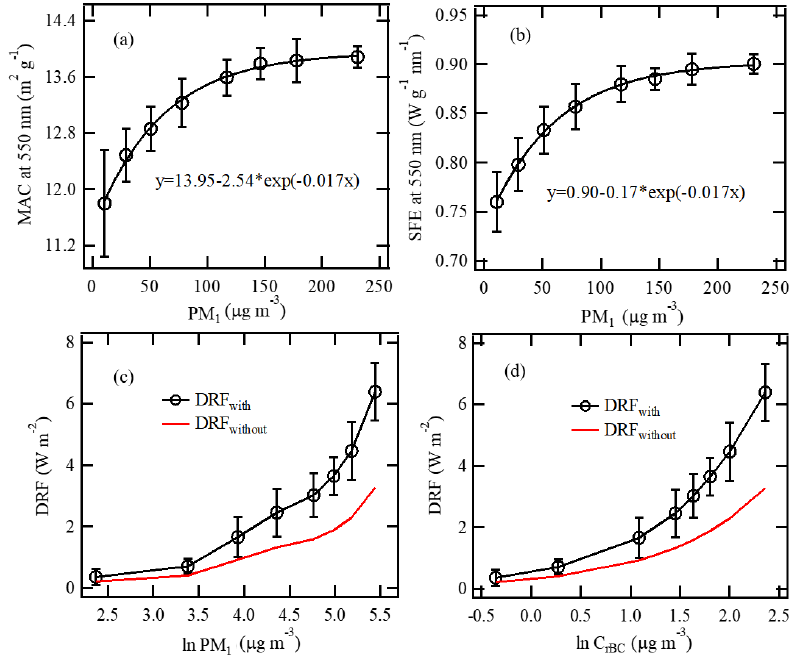
Figure 7. Variations in MAC, SFE and DRF of BC-containing particles under different pollution levels. The DRF values for BC-containing particles were obtained by scaling the average DRF (0.31Wm − 2 , Table S1) of externally mixed BC from various climate models (Bond et al., 2013). The DRF with and DRF without values respectively represent DRF with and without considering the differences of light absorption capability of ambient BC-containing particles under different pollution levels; namely, the DRF with was calculated with scaling factors of the E ab and rBC mass concentration ( C rBC ) and the DRF without was calculated with a scaling factor of C rBC . Variations in DRF with under different pollution levels were due to the change of both the light absorption capability and mass concentration of BC; variations in DRF without were only attributed to the change of rBC mass